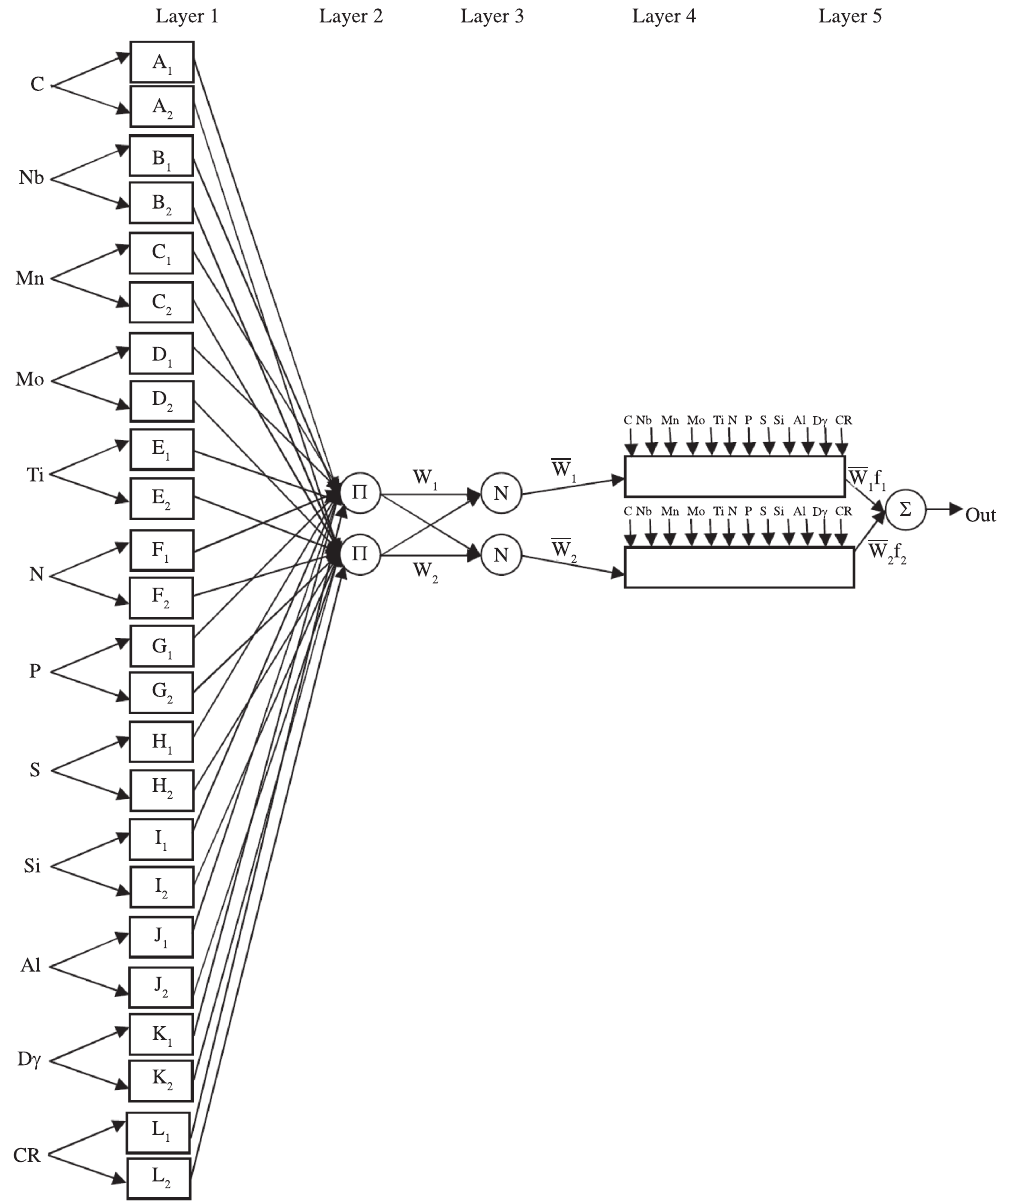
Figure 5. Schematic of ANFIS architecture utilized in this